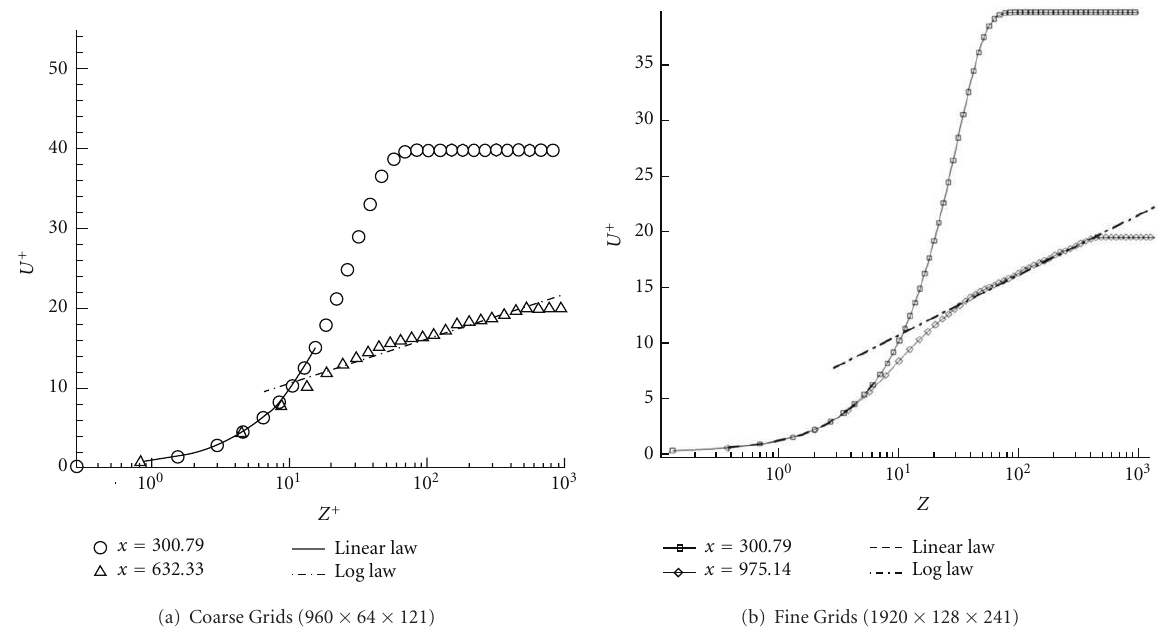
Figure 6: Log-linear plots of the time- and spanwise-averaged velocity profile in wall